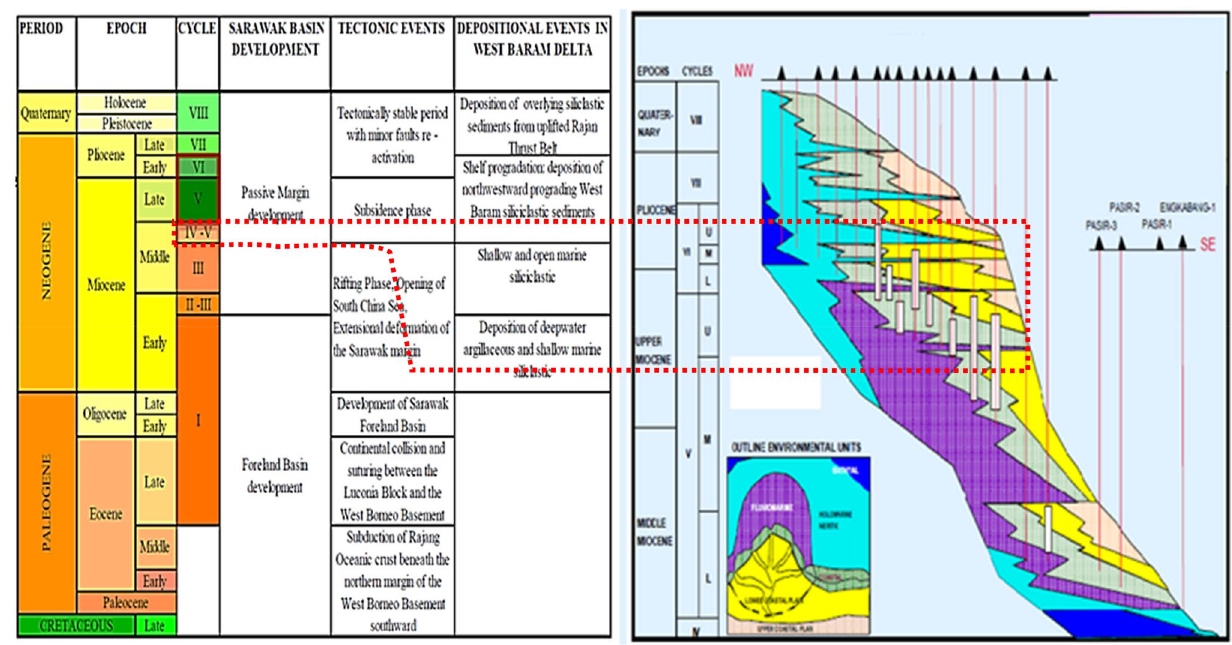
Fig. 2 Generalized stratigraphic column and framework for the Sarawak Basin, tectonics and depositional events in the West Baram delta, modi- fied after Fui (1978), Madon (1999), and Pauzi et al.